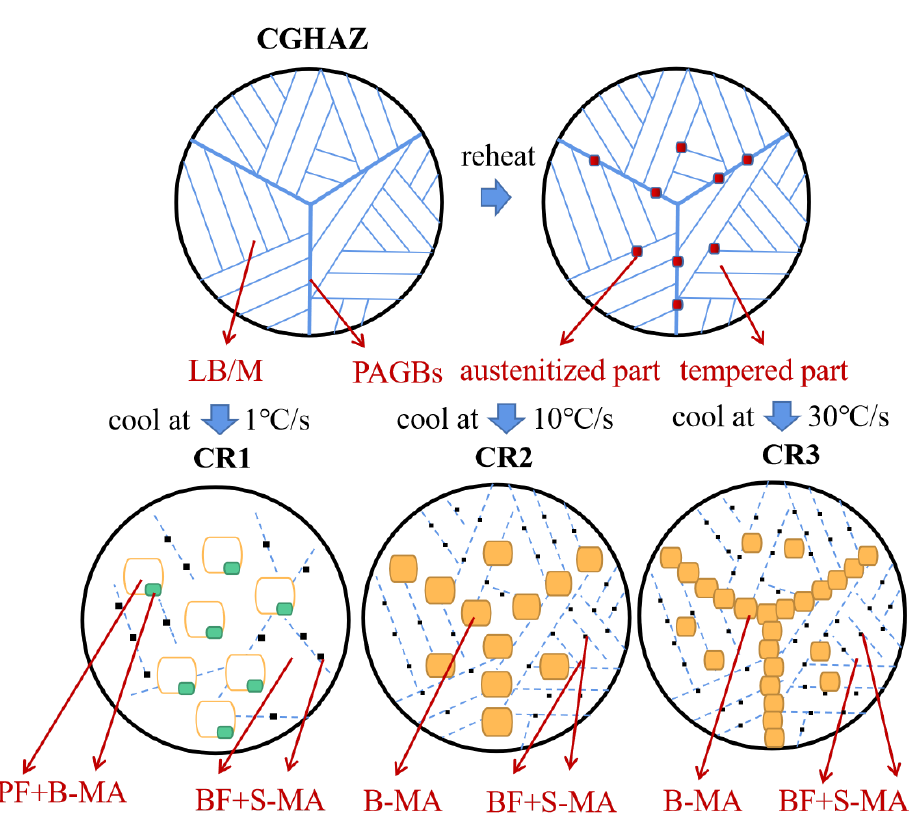
Figure 7. Illustration of microstructure evolution of ICR CGHAZ with different cooling rates.